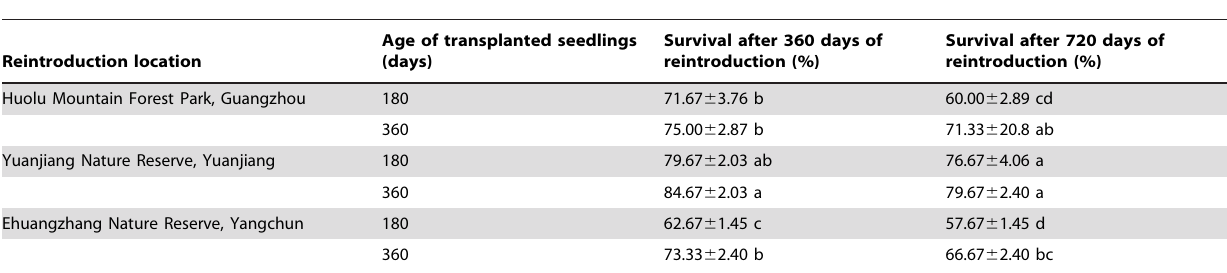
Table 8. Survival rates of different ages of transplanted Renanthera imschootiana seedlings after 360- or 720-day reintroduction.